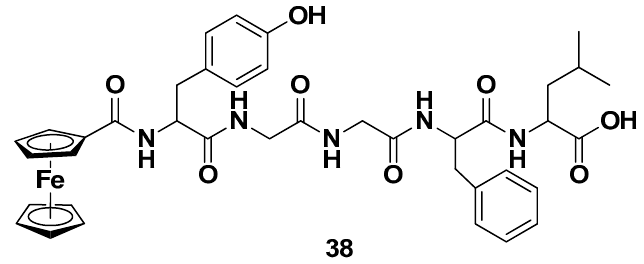
Figure 19. Ferrocene-modified [Leu5]-enkephalin